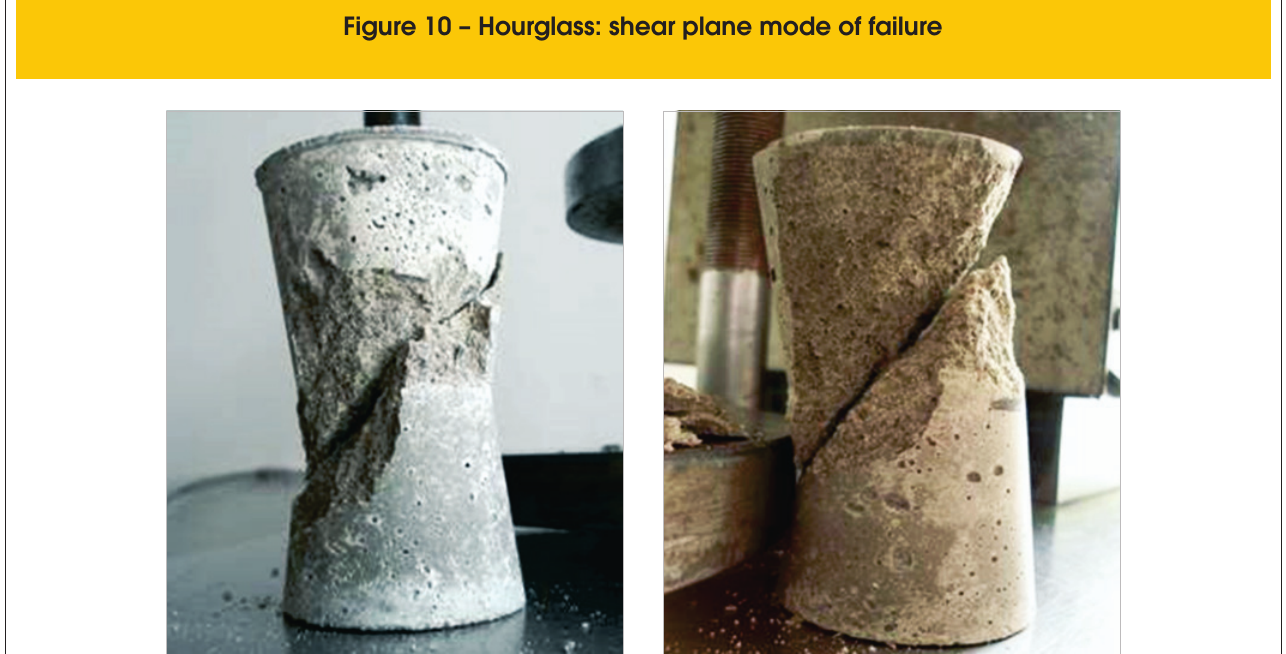
Figure 10 – Hourglass: shear plane mode of